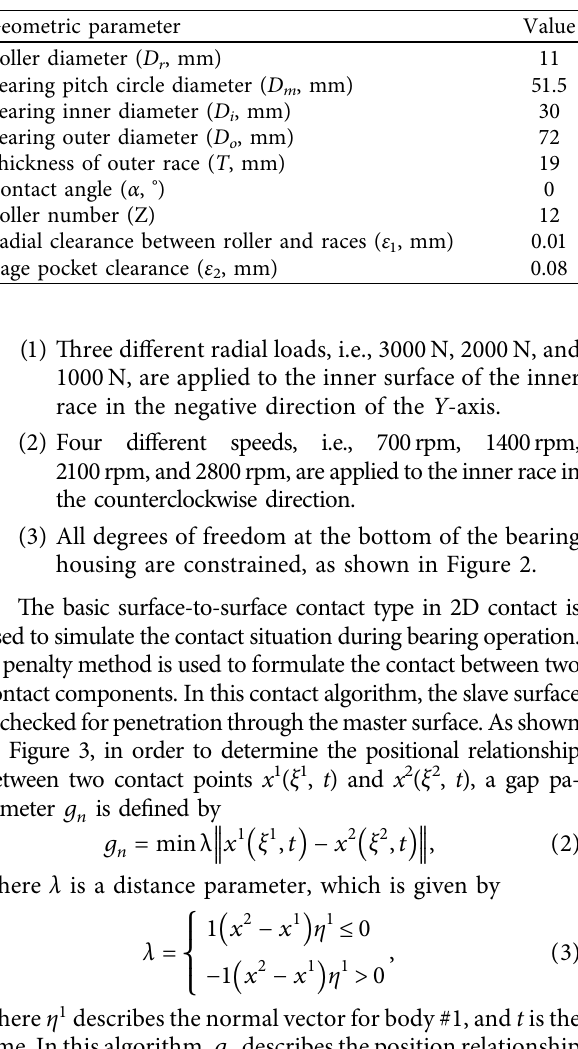
Figure 1: Schematic diagram of defect vibration transmission of the bearing housing system: (a) Defect excitation and (b) structure vibration. Table 1: Geometric parameters of the cylindrical roller bearing NU306 [4].